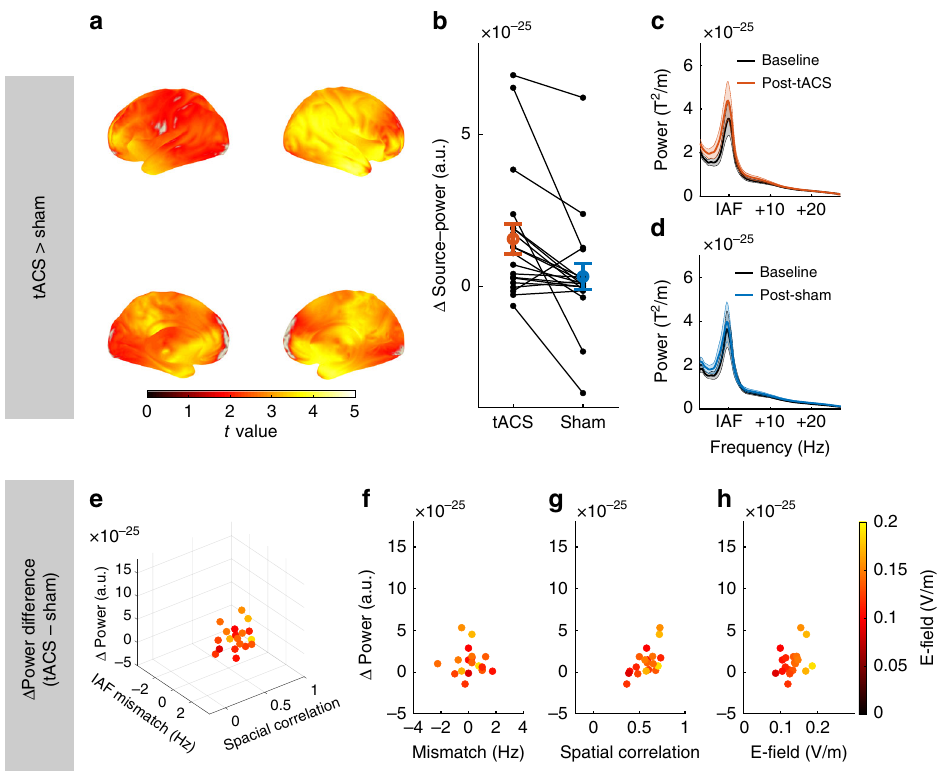
Fig. 6 Results of within-subject replication experiment. a Statistical map contrasting the power increase from the pre- to the post-stimulation block between experimental conditions (tACS vs. sham) in the α -band. Statistical map shows t values, thresholded at an α -level of 0.05. b Power increase within the cluster for each of the experimental conditions. Black dots/lines represent the power increase of each individual subjects in the experimental conditions. c Power spectra before and after tACS (average over all gradiometer sensors and participants). All spectra were aligned to participants ’ individual α -frequency (IAF) before averaging. d Power spectra before and after sham stimulation. e Individually sham-controlled tACS effect (power increase relative to baseline after tACS − power increase relative to baseline after sham) as a function of function of frequency mismatch between tACS frequency and the dominant frequency during baseline, the spatial correlation between the simulated electric fi eld and the source-level α -topography during baseline, and the maximum fi eld strength in gray and white matter compartments. Each dot represents data of a single subject. f – h Same data as in e shown for each predictor of the regression model. Error bars and shaded areas depict standard error of the mean (S.E.M.). Source data are provided as a Source Data fi